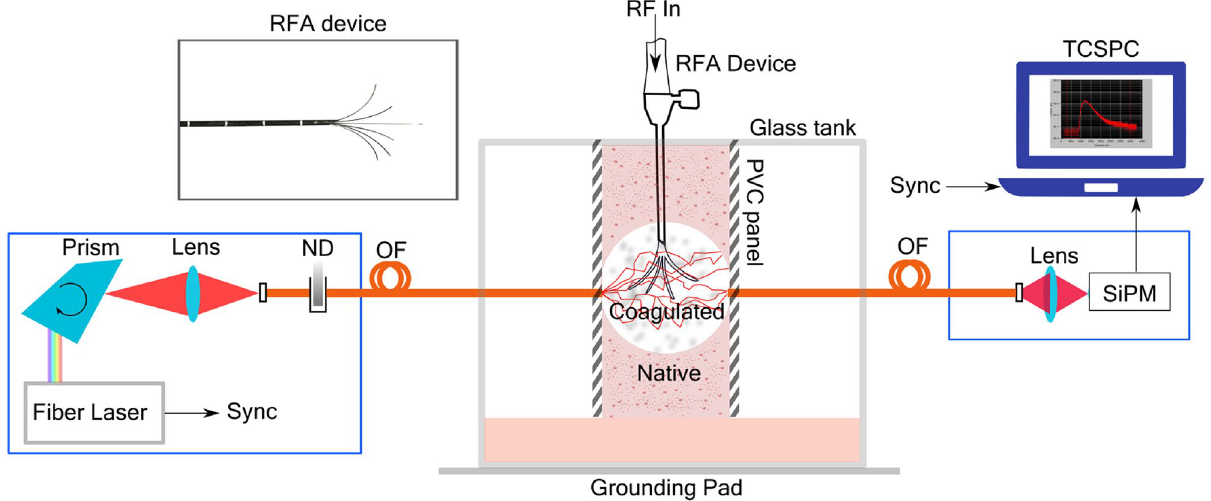
Figure 1. Time-resolved diffuse optical spectroscopy during Radiofrequency ablation (RFA). The measurement of optical properties was performed in transmittance geometry. Light from a broadband (450–1750 nm) fiber treatment is held between two black PVC panels in a glass tank. The RFA device is introduced to the center of the sample and the grounding pad to the aluminum plate at the bottom of the tank. A layer of chicken tissue is placed on top of the grounding pad to increase the surface area which facilitates a uniform growth of thermal lesion in the tissue through the tissue. Alternating current is applied between the RFA device and the grounding pad for heating of the tissue. The detection fiber on the other side of the sample collects the diffusively transmitted light and focuses it into a Silicon Photomultiplier (SiPM) which is then analyzed using a PC